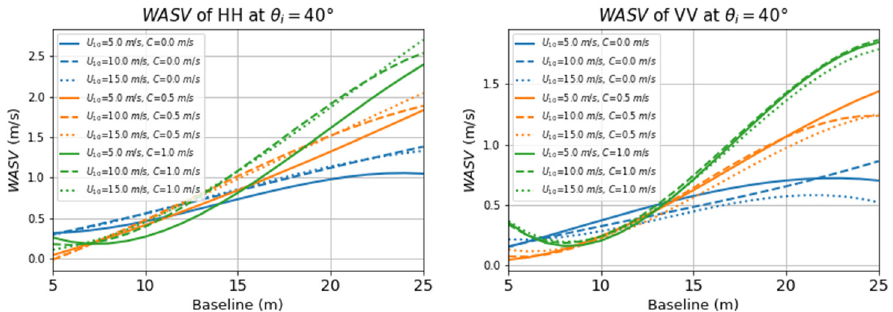
Figure 7. The relationship between WASV magnitude and baseline at a wind speed of 10 m/s for HH and VV polarizations. The swell direction, amplitude, and wavelength were 0°, 0.5 m, and 200 m, respectively. Other input parameters were set to the values indicated in Table 1.